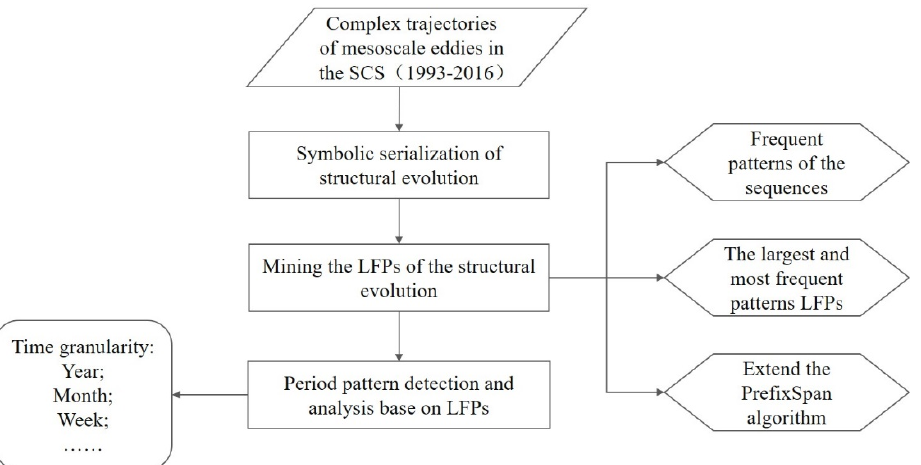
Figure 2. A flow chart showing the major components of the periodic pattern mining of structural evolution (PPSE) method.